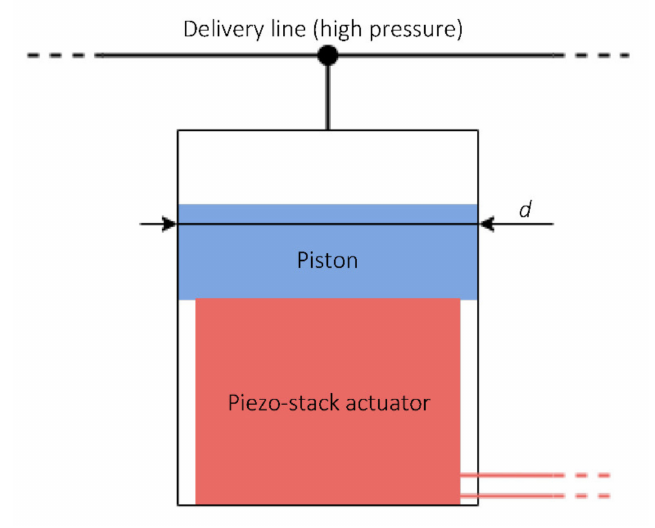
Figure 1. Schematic of piezo-stack actuated piston active method.